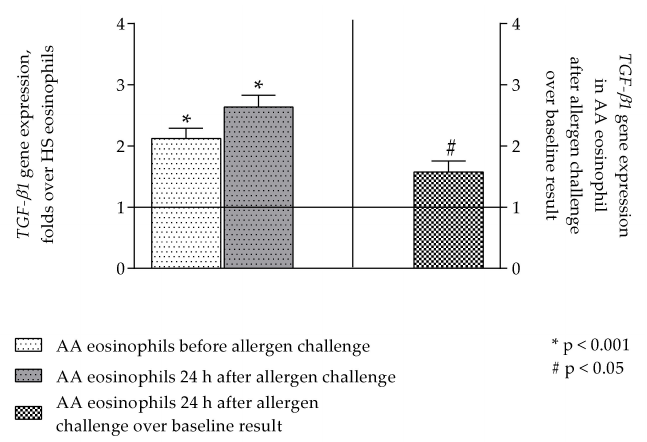
Figure 1. TGF- β 1 expression in asthmatic eosinophils before and 24 h after allergen challenge. Data represented as mean ± SEM evaluated as folds over healthy subjects’ eosinophils and as folds 24 h after allergen challenge over baseline asthmatic eosinophils. TGF- β 1 –transforming growth factor β 1 gene; n = 12, * p < 0.001 comparing with HS group; # p < 0.05 comparing with eosinophils before allergen challenge, n = 12. Statistical analysis—Wilcoxon matched-pairs signed-rank test for analysis between the dependent groups; Wilcoxon signed-rank test for analysis against control ASM cells.